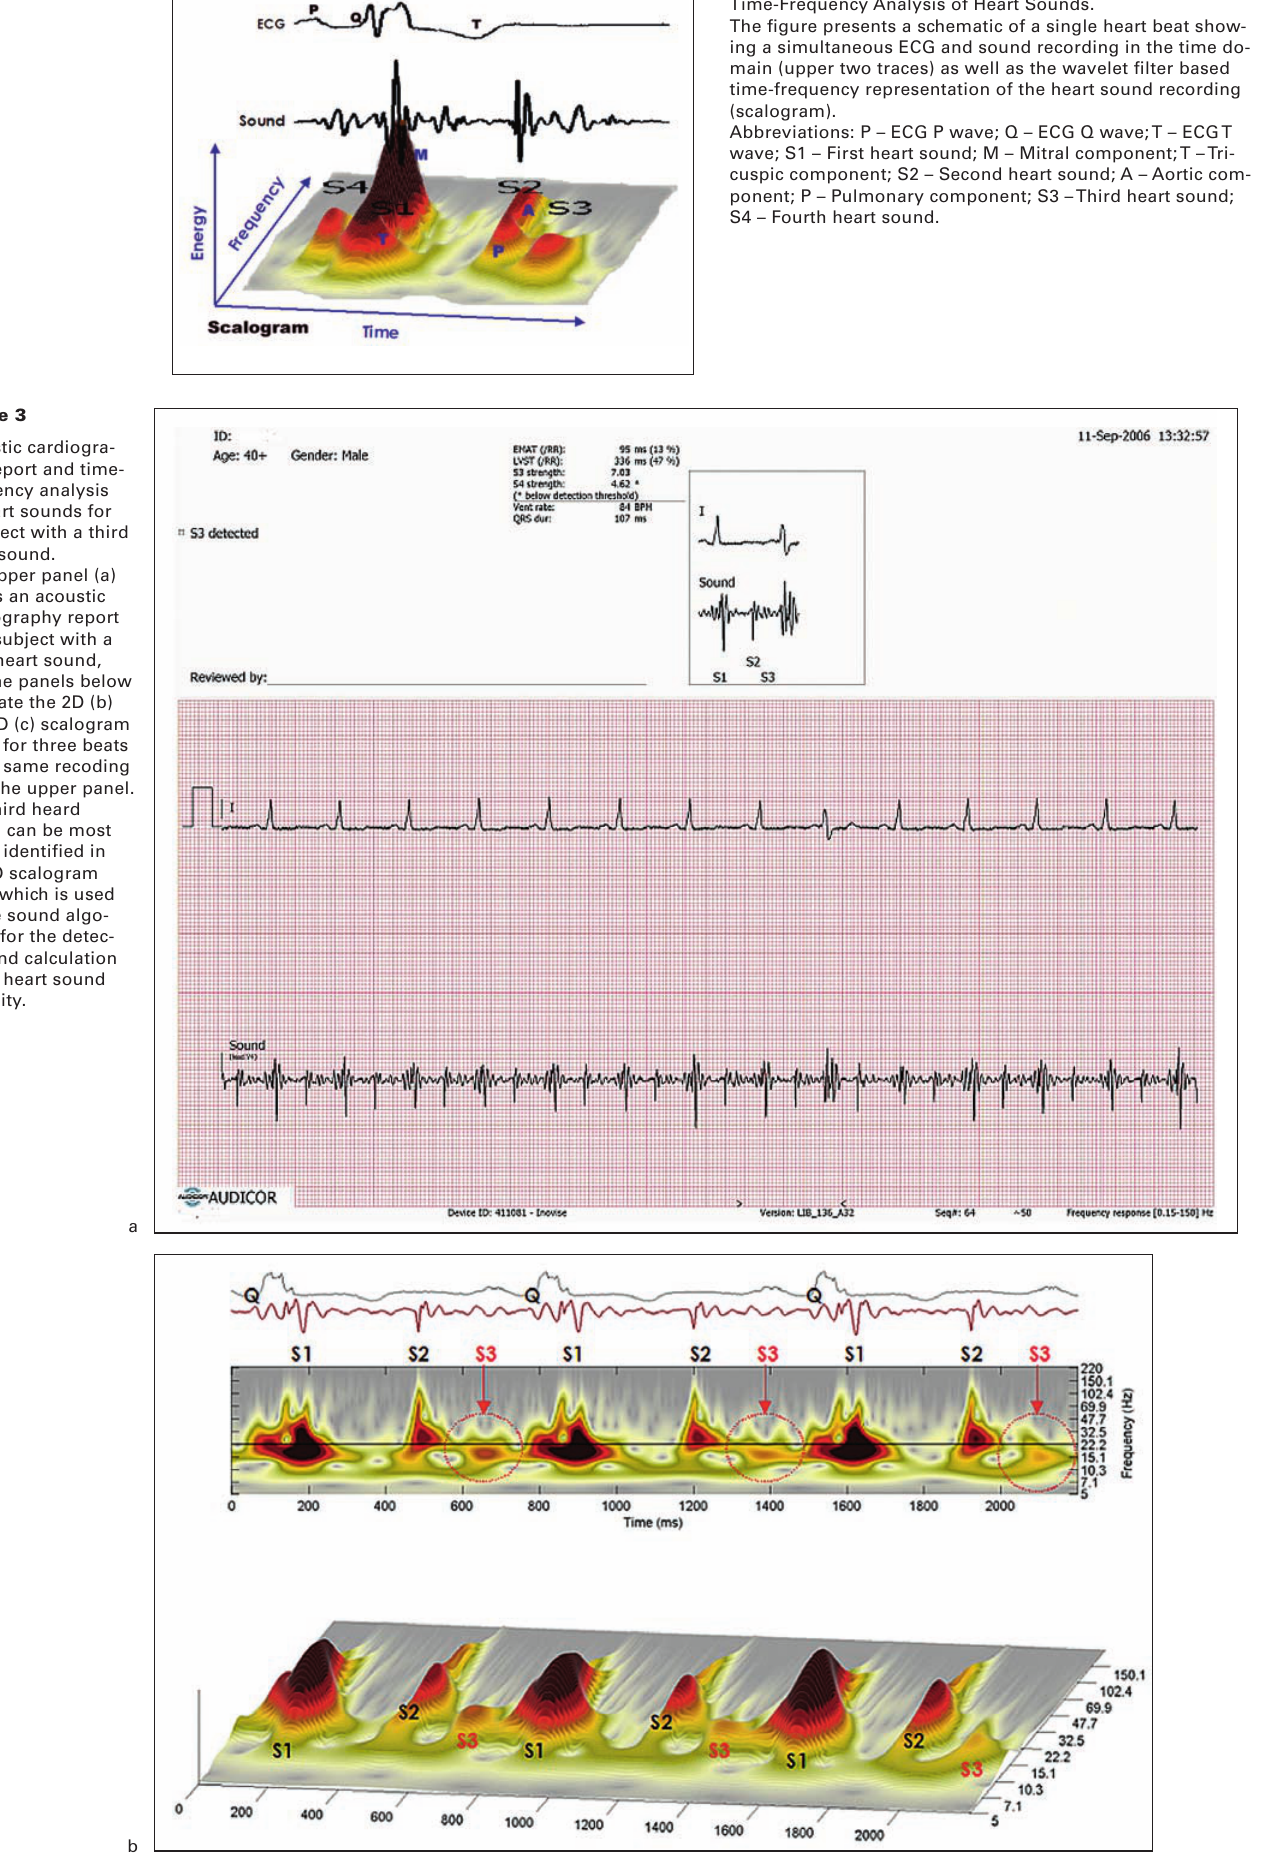
Time-Frequency Analysis of Heart Sounds. The figure presents a schematic of a single heart beat show- ing a simultaneous ECG and sound recording in the time do- main (upper two traces) as well as the wavelet filter based time-frequency representation of the heart sound recording (scalogram).